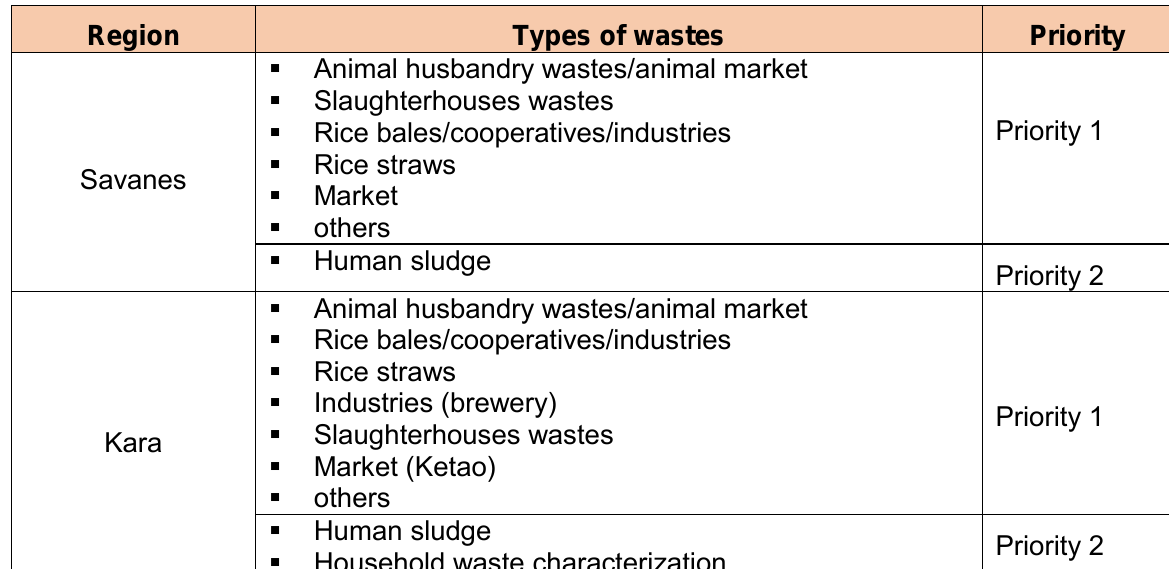
Table 1 Types of prioritized wastes in each